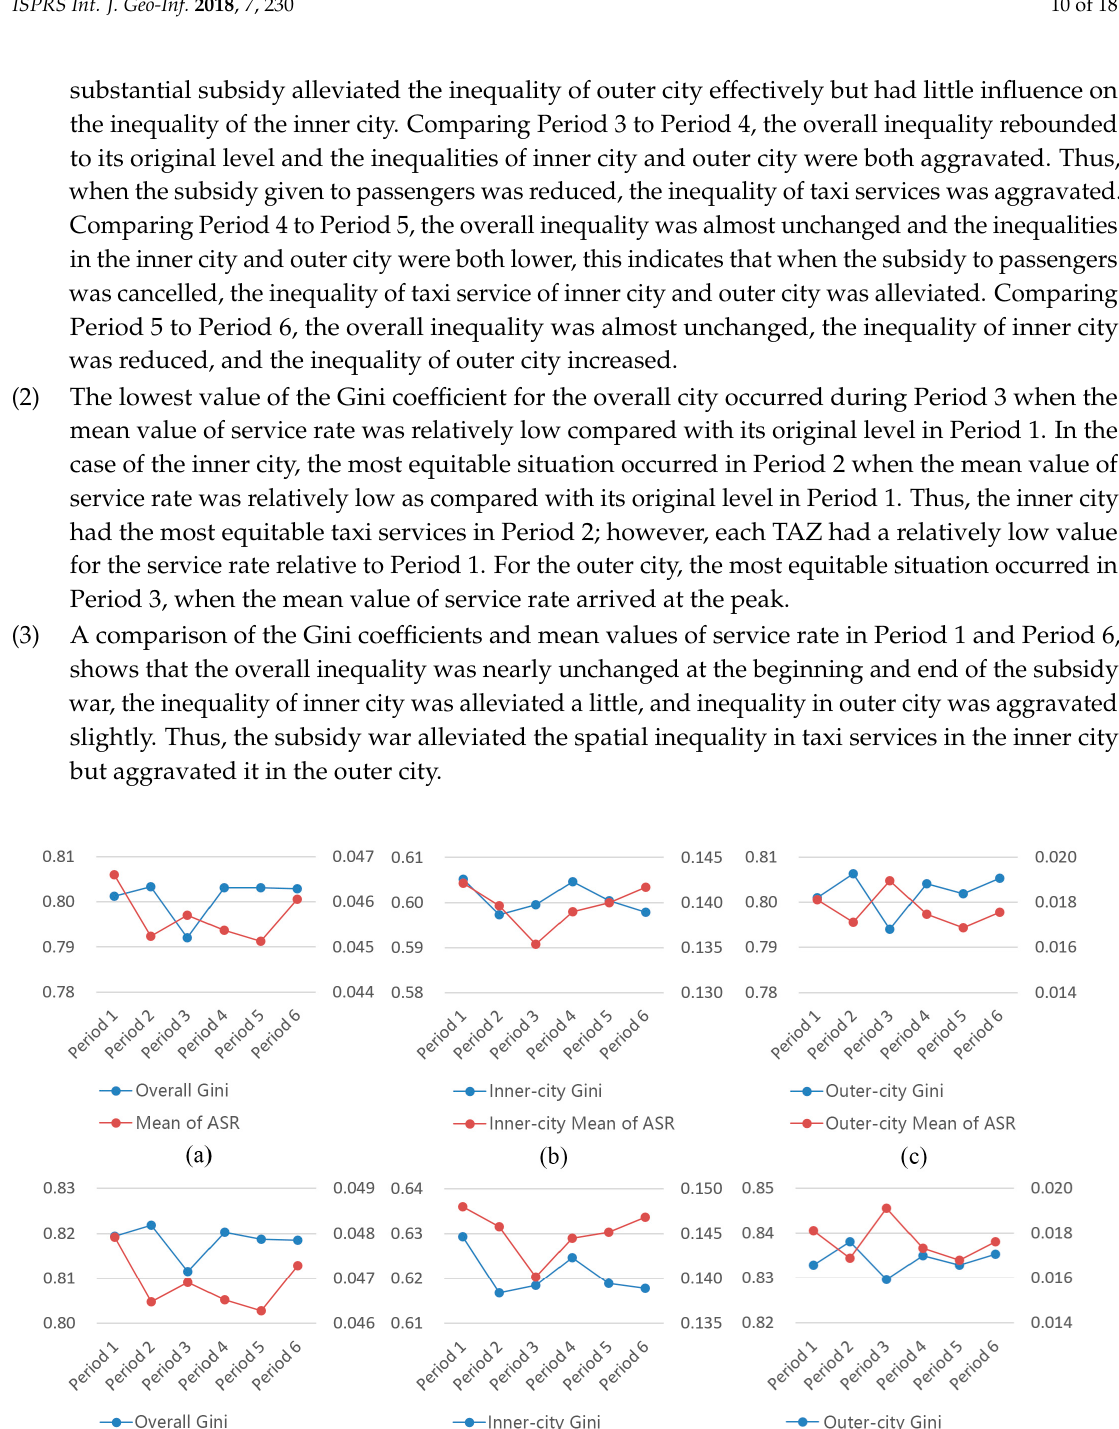
Table 4. The overall mean of the ASR/DSR, the inner city mean of the ASR/DSR, and the outer city mean of the ASR/DSR on weekends.